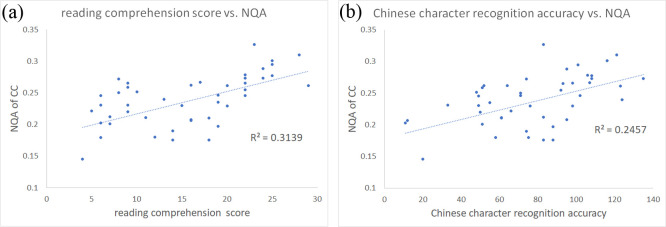
The scatter plot of the reading comprehension score/Chinese character recognition accuracy and diffusion indices.(a) The scatter plot showing all individuals’ reading comprehension score and NQA from the corpus callosum region. (b) The scatter plot showing all individuals’ Chinese character recognition accuracy and NQA from the corpus callosum region.